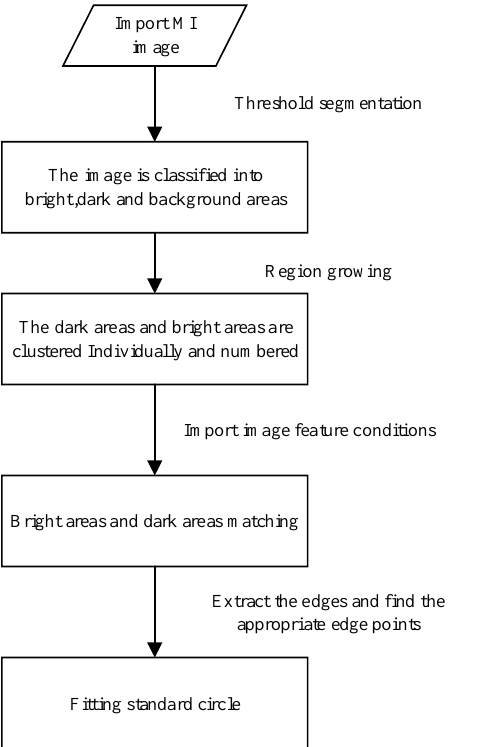
Figure 1. Automatic crater detection algorithm based on feature matching